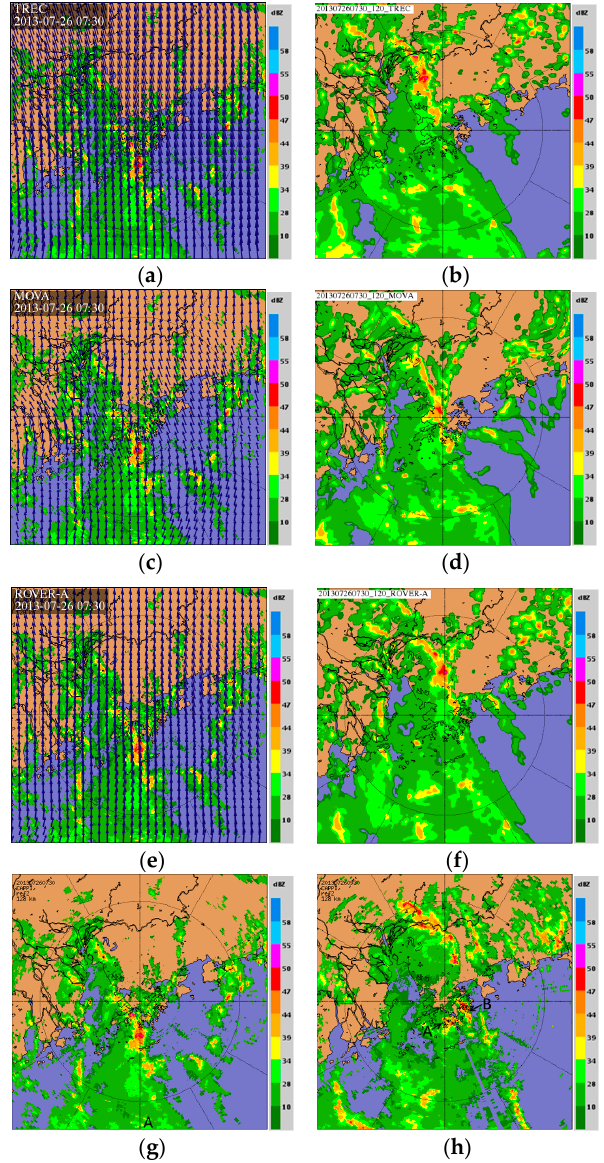
Figure 5. Reflectivity and motion fields based at 07:30 (HKT/UTC + 8) on 26 July 2013 (base time). ( a ) Reflectivity and motion field of TREC at base time; ( b ) Forecast reflectivity of TREC at 2 h from the base time; ( c ) Reflectivity and motion field of MOVA at base time; ( d ) Forecast reflectivity of MOVA at 2 h from the base time; ( e ) Reflectivity and motion field of ROVER at base time; ( f ) Forecast reflectivity of ROVER at 2 h from the base time; ( g ) Actual radar reflectivity at base time; and ( h ) Actual radar reflectivity at 2 h from the base time.